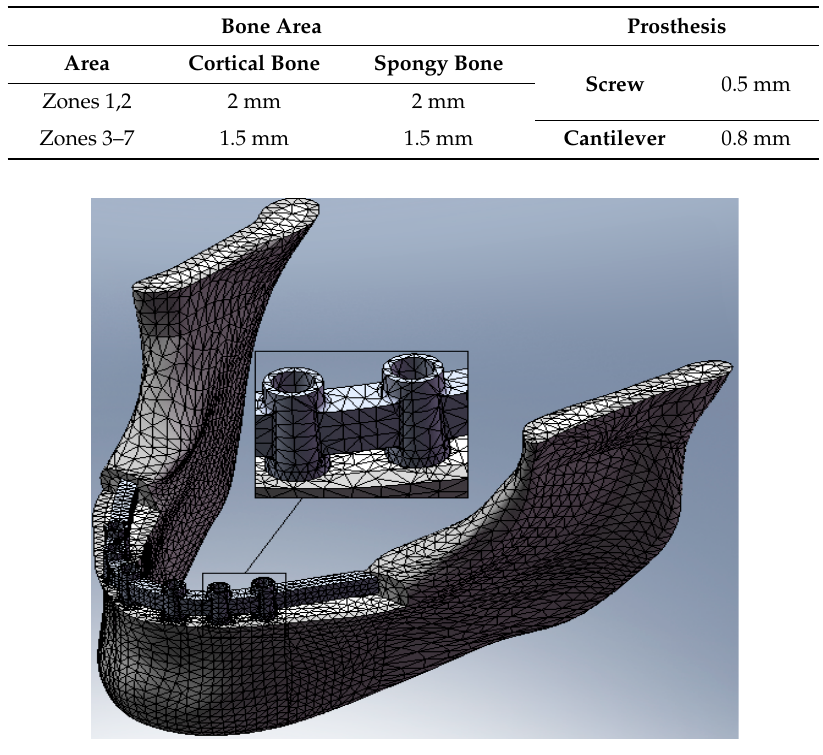
Figure 9. Sample of the mesh of the bone mandible, of the bar, and of the fixture placed.